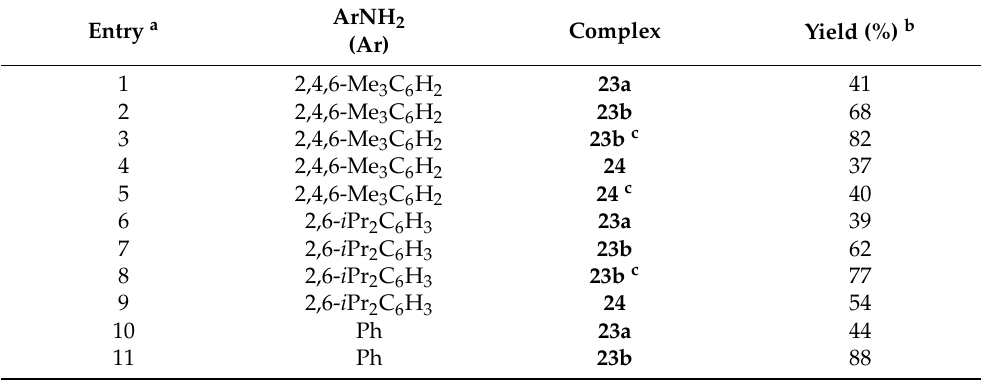
Figure 10. Gold(I) complexes with fused polycyclic aromatic hydrocarbons as ligands. The 23a – b and 24 complexes were tested as catalysts for the hydroamination of pheny- lacetylene (Table 7) with substituted anilines (for reaction see Table 1). Table 7. Hydroamination of phenylacetylene with substituted anilines .